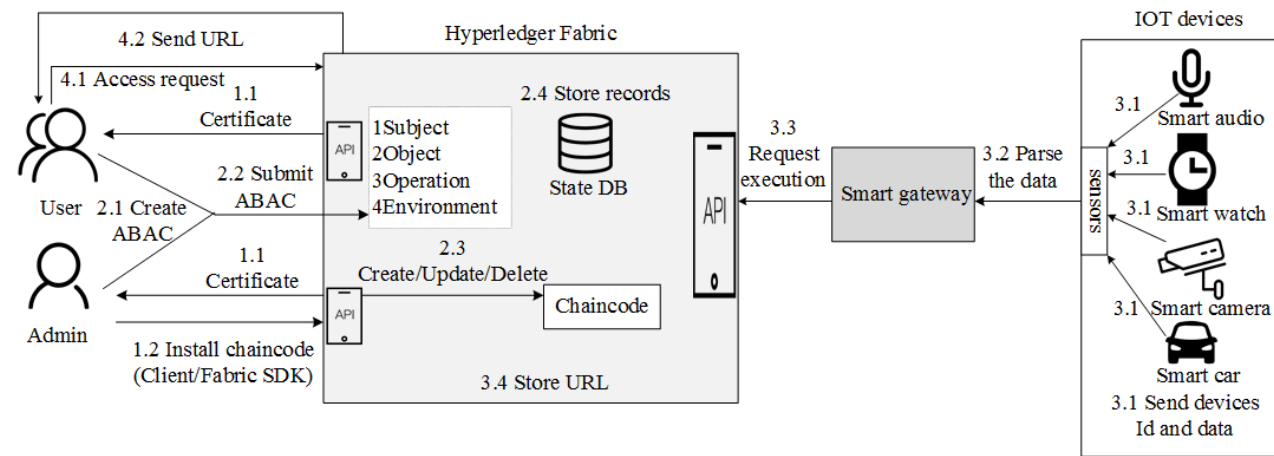
Figure 11. Reconstruction diagram of reference [32].